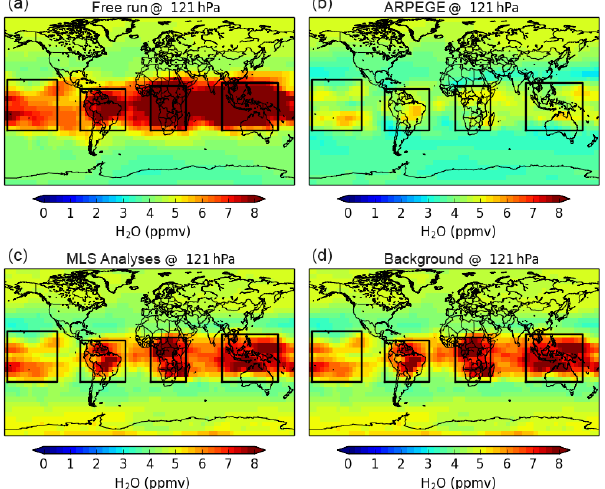
Figure 10. Monthly averaged H 2 O fields at 121hPa in January 2012 in the model space (in the model grid and time samplings) from the free run (MOCAGE, a ), ARPEGE (b) , MLS analyses (assimila- tion, c ) and the background (d) .